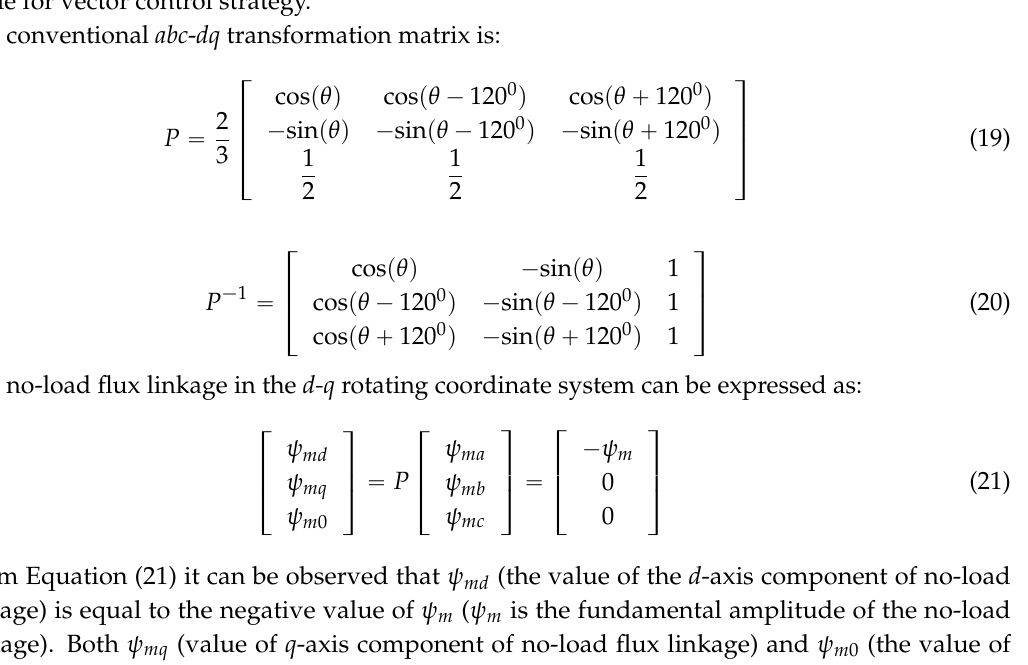
Figure 11. The average value of ψ md , ψ mq and ψ m0 based on the abc ‐ dq transformation of 3 ‐ D FEM